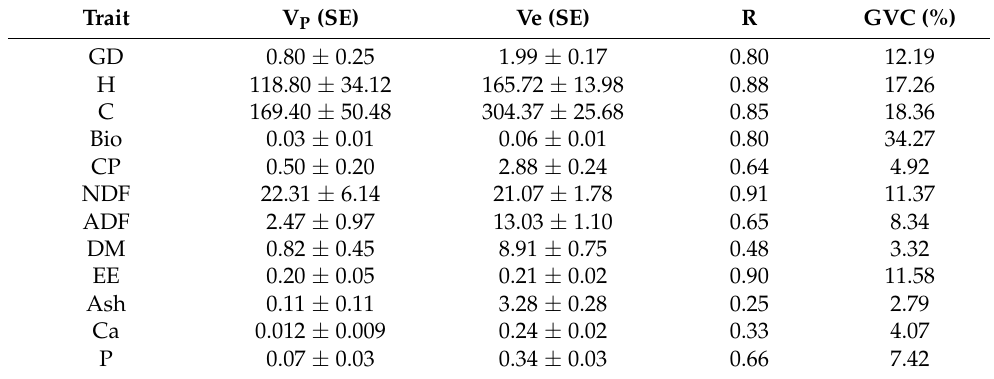
Table 4. Variance components, repeatability, and genetic variation coefficients of the provenances.